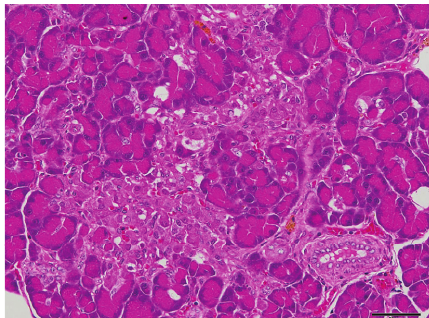
F 3: Histological analysis, HE stain. Pathological �ndings such as atrophy and �brosis in pancreatic islets of female SDT fatty rat at 24 weeks of age. Bar = 50